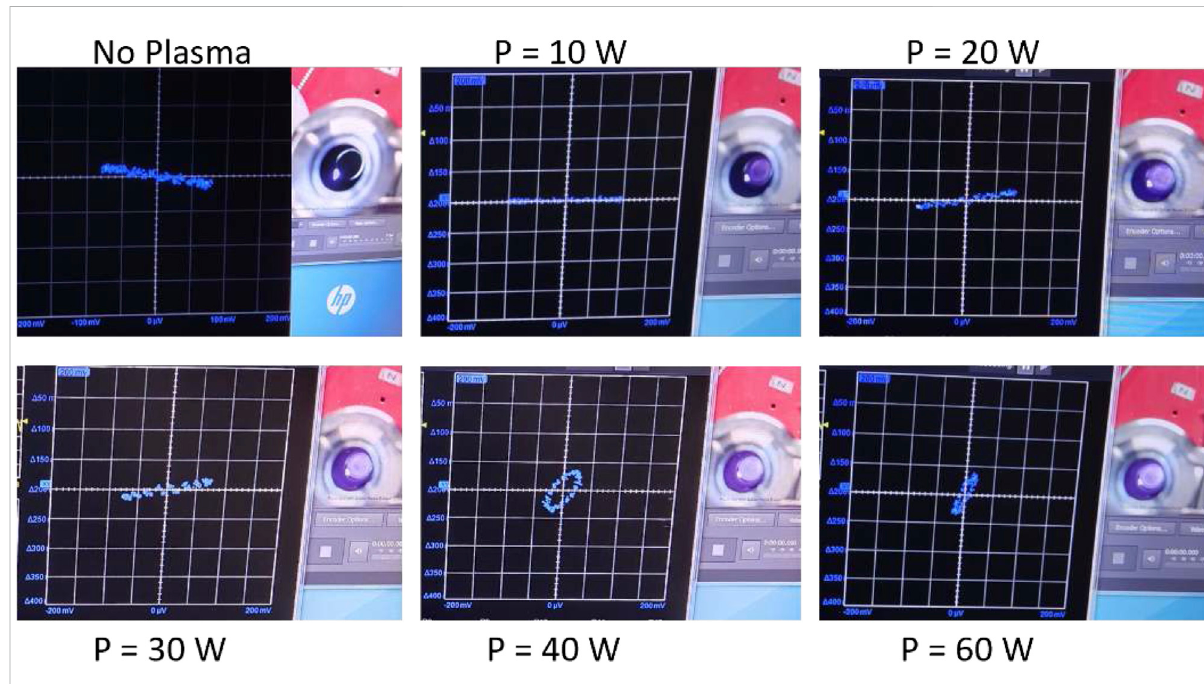
FIGURE 13 Visual inspection of the optical emission observed by a webcam thought a quartz window (on the right of each picture) in function of the pumping power. On the left of each picture is shown the screen of the scope and the corresponding Lissajous fi gure. The clockwise start with turn- off plasma.